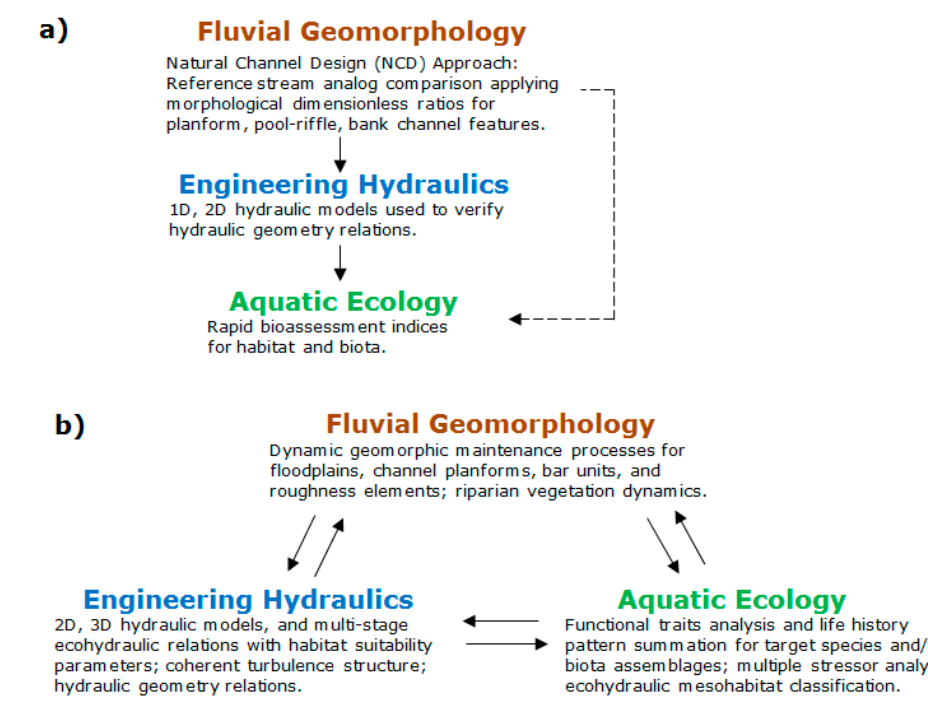
Figure 1. Multidisciplinary design processes for stream restoration: ( a ) as commonly practiced; and ( b ) per an ecohydraulics mesohabitat approach.